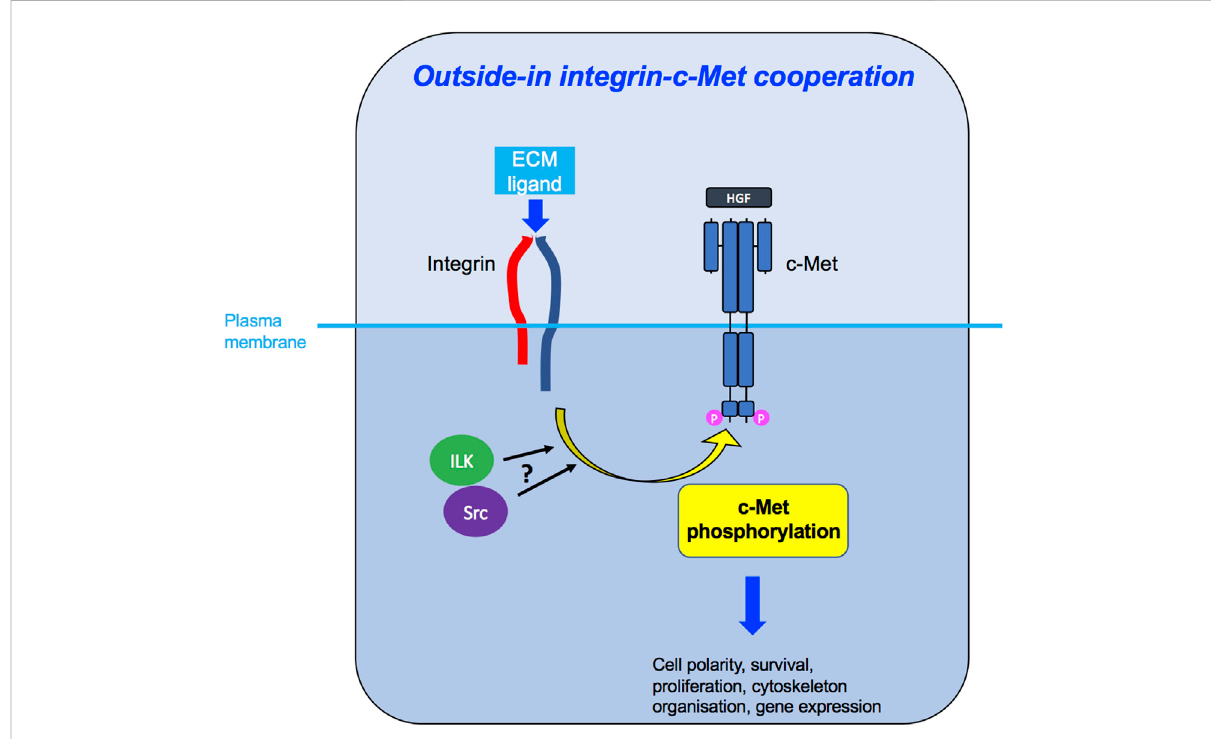
FIGURE 6 Outside-in integrin-c-Met cooperation. Integrin activation, through binding to its ligand in the ECM, leads to downstream c-Met phosphorylation, potentially via ILK and/or Src kinases, enabling c-Met-induced intracellular signalling and diverse cellular